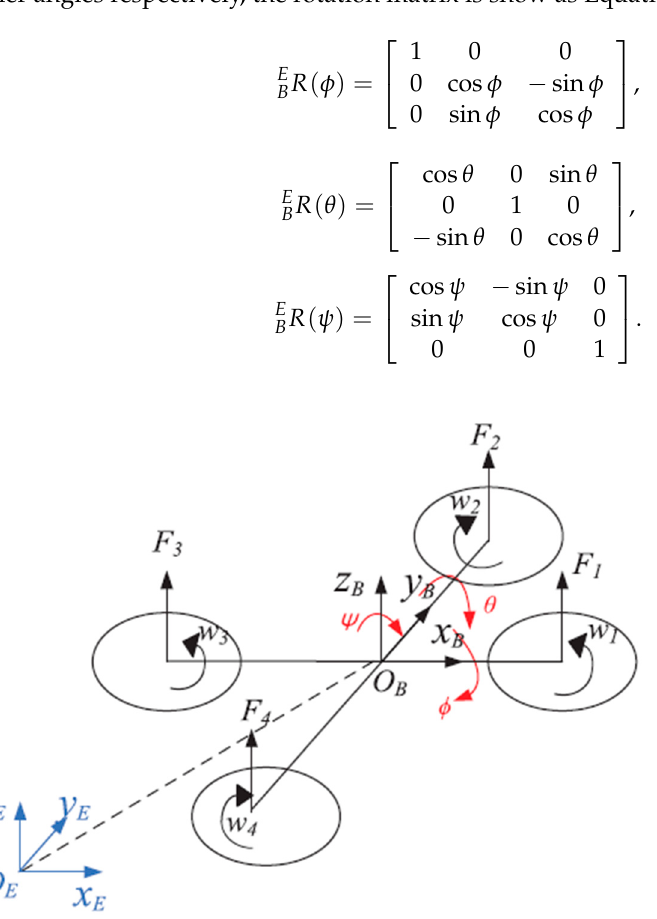
Figure 2. Schematic diagram of quadrotor.